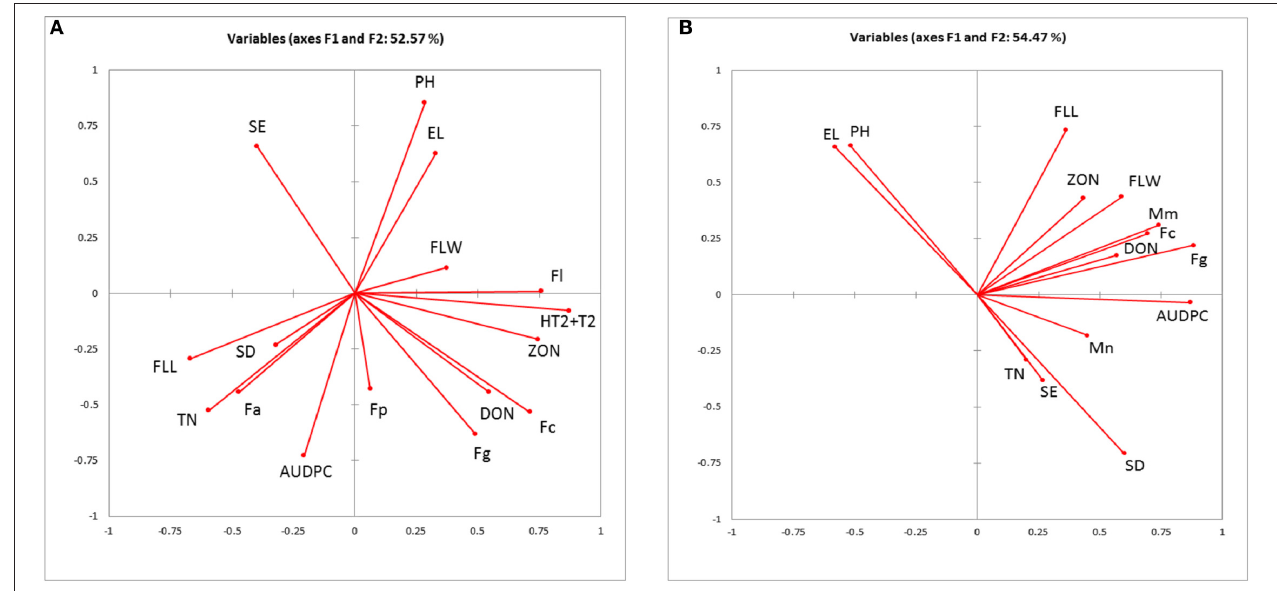
FIGURE 2 | Biplot of the principal component analysis of the Area under the disease progress curve (AUDPC), measured ear traits, quantified fungal DNA and mycotoxins from (A) 2010 and 2011 field experiments; (B) 2012 field experiment. El, ear length; SE, spikelets per ear; SD, spikelet density; Fa, F. avenaceum ; Fc, F. culmorum ; Fg, F. graminearum ; Fl, F. langsethiae ; Fp, F. poae ; Mm, M. majus , Mn, M. nivale ; DON, deoxynivalenol, HT2 + T2 and ZON, zearalenone.